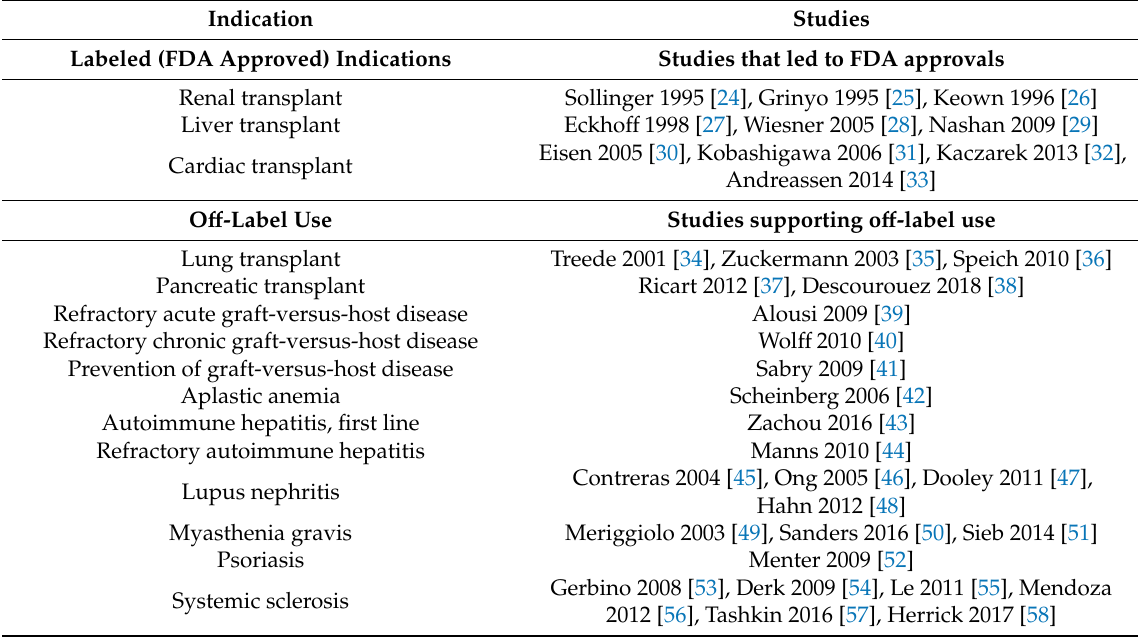
Figure 3. MPA and its metabolites: phenolic MPA-glucuronide (MPAG), phenolic 7-0-glucoside (M1), acyl glucuronide (M2), and acyl-glucoside (M3), a CYP450 oxidation product. Table 1. Labeled and off-labeled indications of MMF .